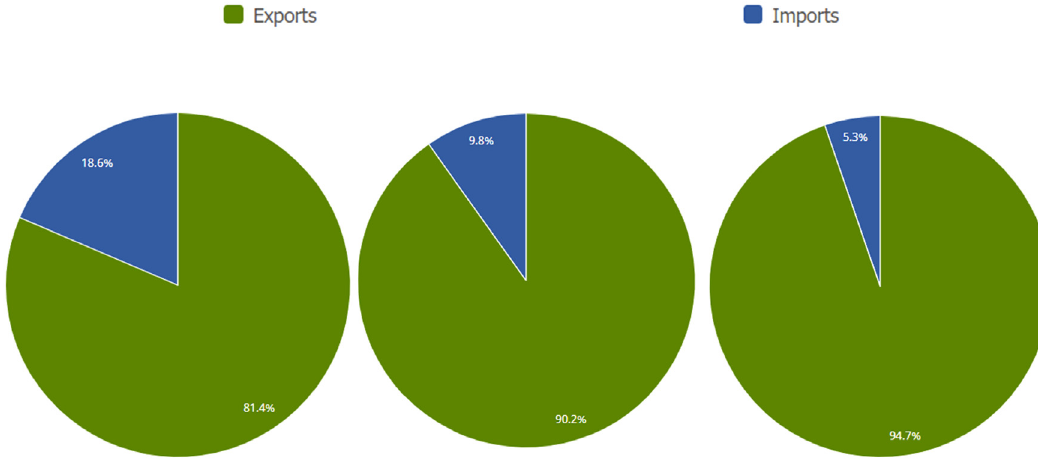
Figure 2: Import and export Polish molasses in 2008, 2015, and 2019 ( from left ) [ 116 ]